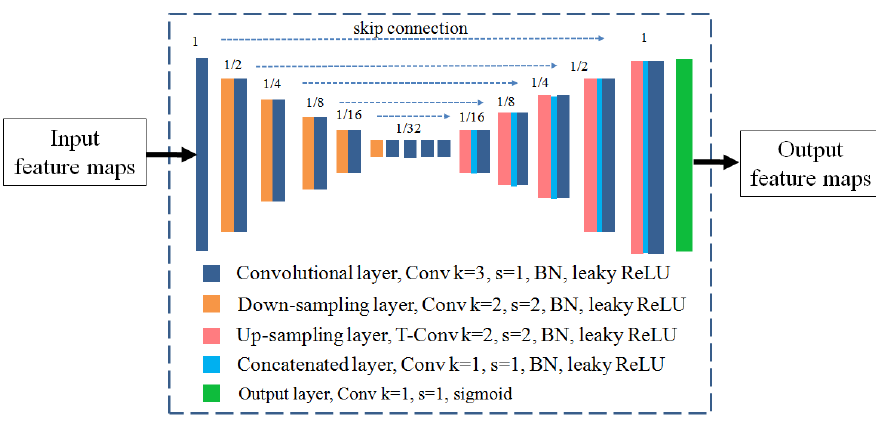
Figure 1. Architecture diagram of the FrANet.